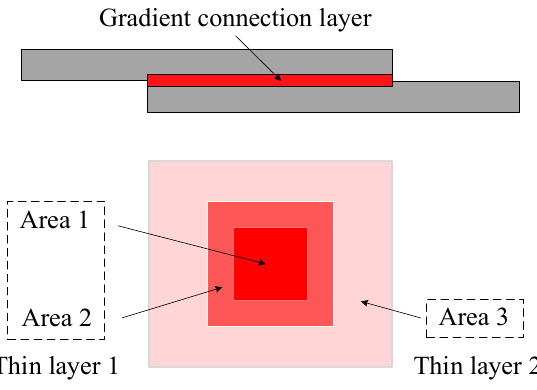
Figure 12. The influence area of the bolt connection, which is divided into three areas.